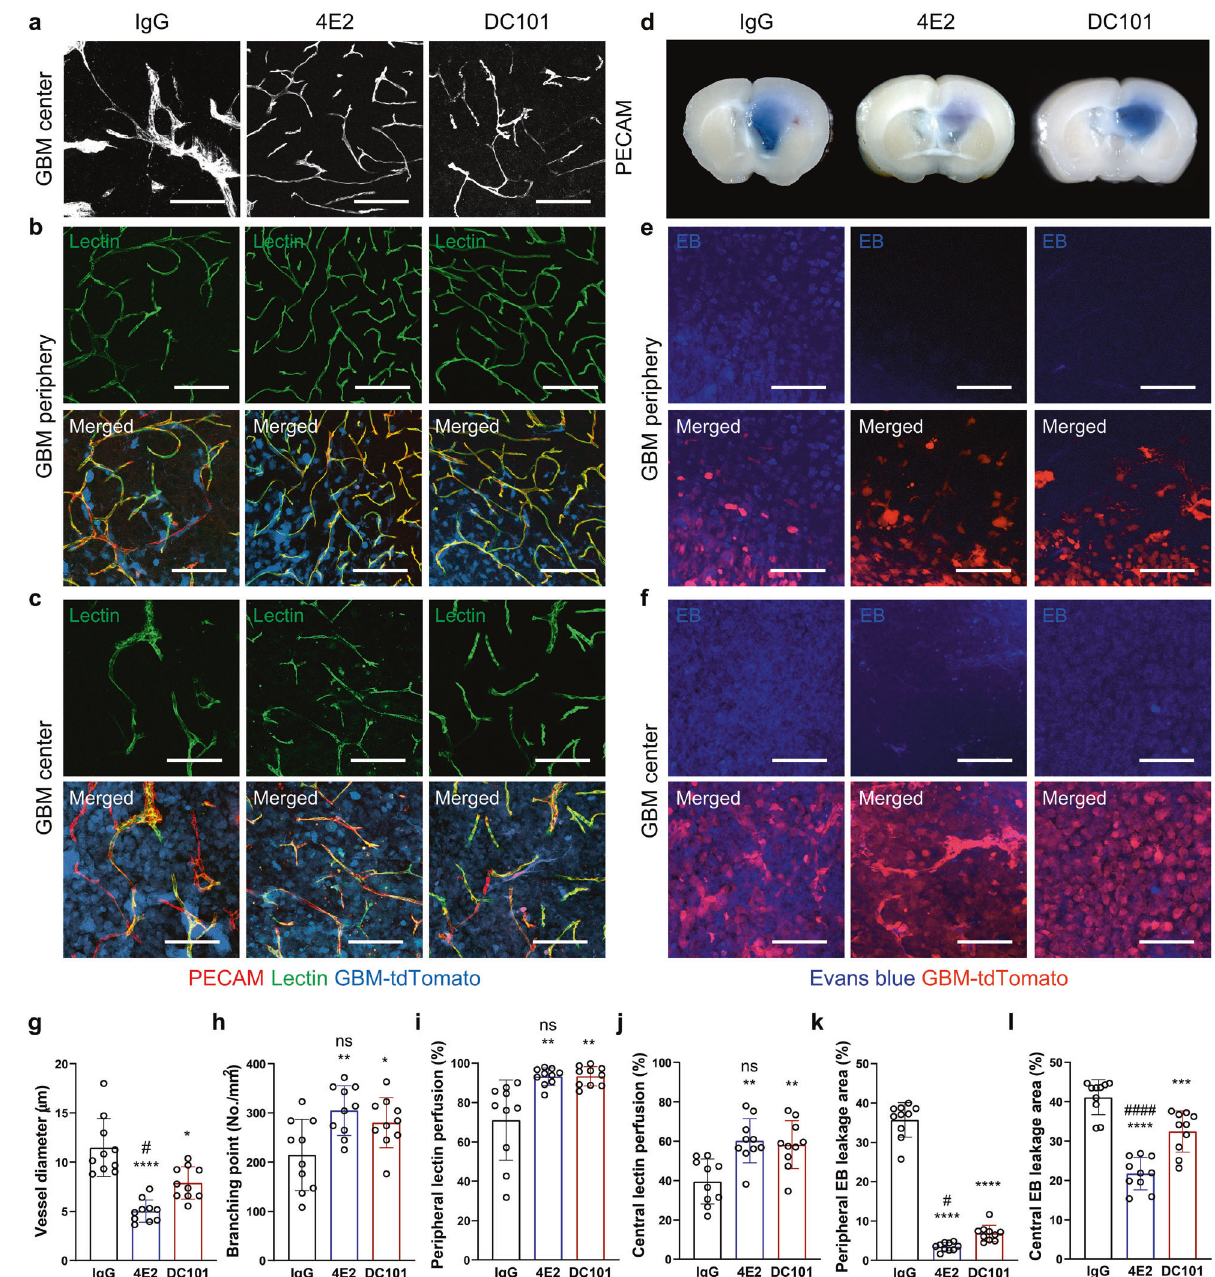
Fig. 5 Antibody-based Tie2 activation and VEGFR2 blockade restore vascular morphology and function in GBM. Vascular changes in